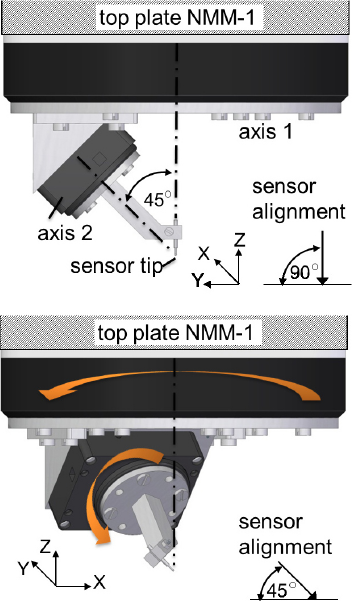
Figure 7. Schematic of the rotary kinematic chain, operated at 90 ◦ and 45 ◦ sensor alignment.